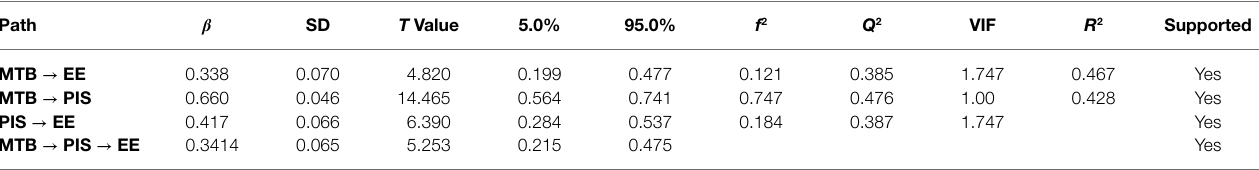
TABLE 5 | Significance and relevance of direct and indirect paths coefficients.